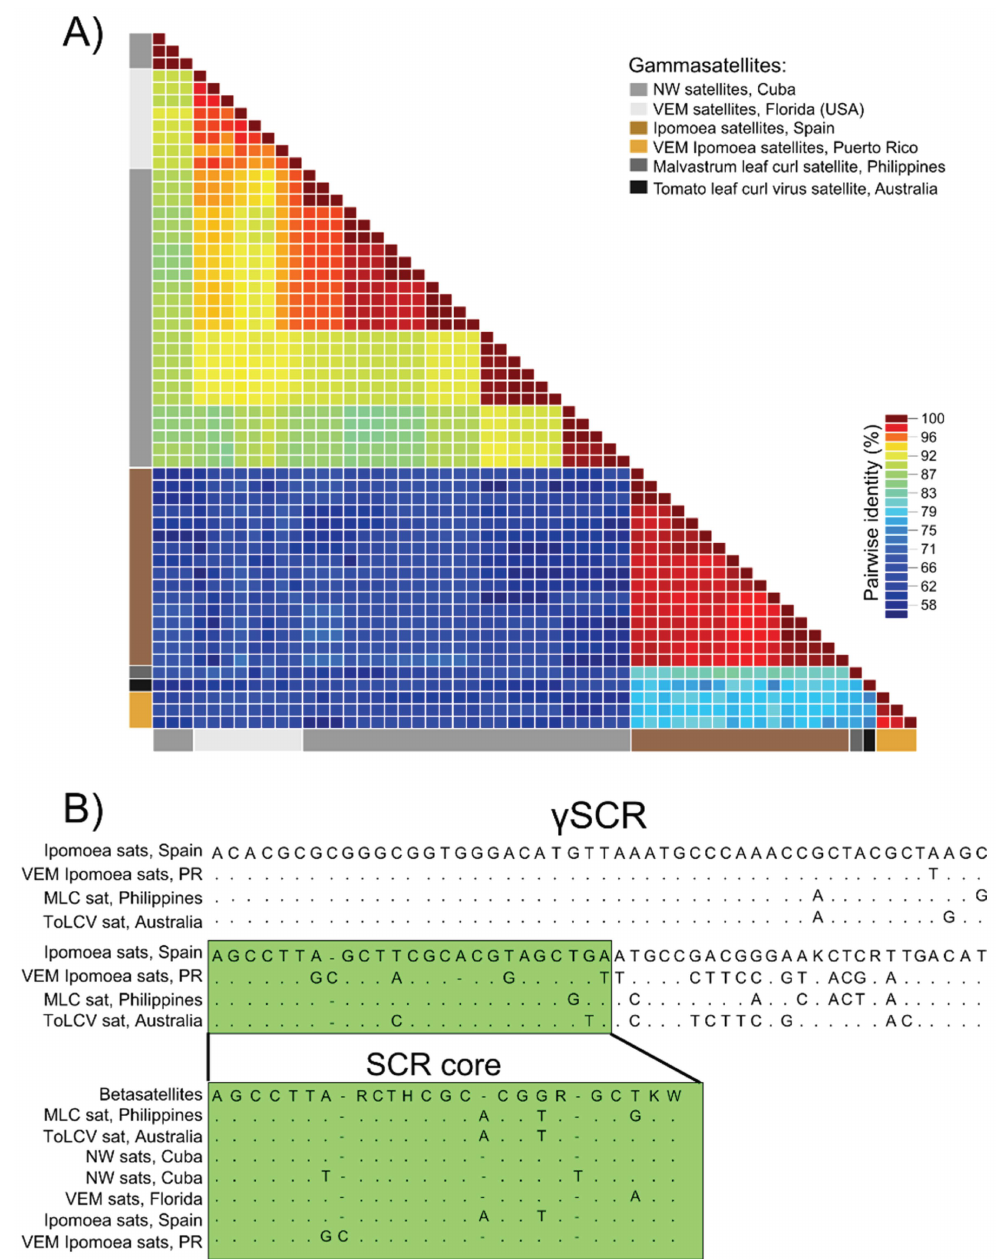
Figure 3. ( A ) Two-dimensional color-coded matrix depicting genome-wide pairwise identities observed among gammasatellites and ( B ) consensus sequences observed within a conserved satellite common region shared among various gammasatellites ( γ SCR). Mixed bases in the consensus sequences include K (G/T), R (A/G), W (A/T), and H (A/C/T). The γ SCR was observed in Ipomoea satellites (Ipomoea sats) as well as tomato leaf curl virus sat (ToLCV sat) and malvastrum leaf curl satellite (MLC sat). A conserved 23 nt stretch (positions 663–686; labelled SCR core) found within the γ SCR (positions 613–711) shares high pairwise identities with betasatellites and all gammasatellites reported to date, including novel New World satellites (NW sats) identified in Cuba and satellites identified in whiteflies from Florida, USA (VEM sats). Nucleotide positions are based on VEM Ipomoea begomovirus satellite 1. A list of sequences used for calculating identity scores among gammasatellites as well as betasatellites used for investigating the SCR core is provided in Supplemental File